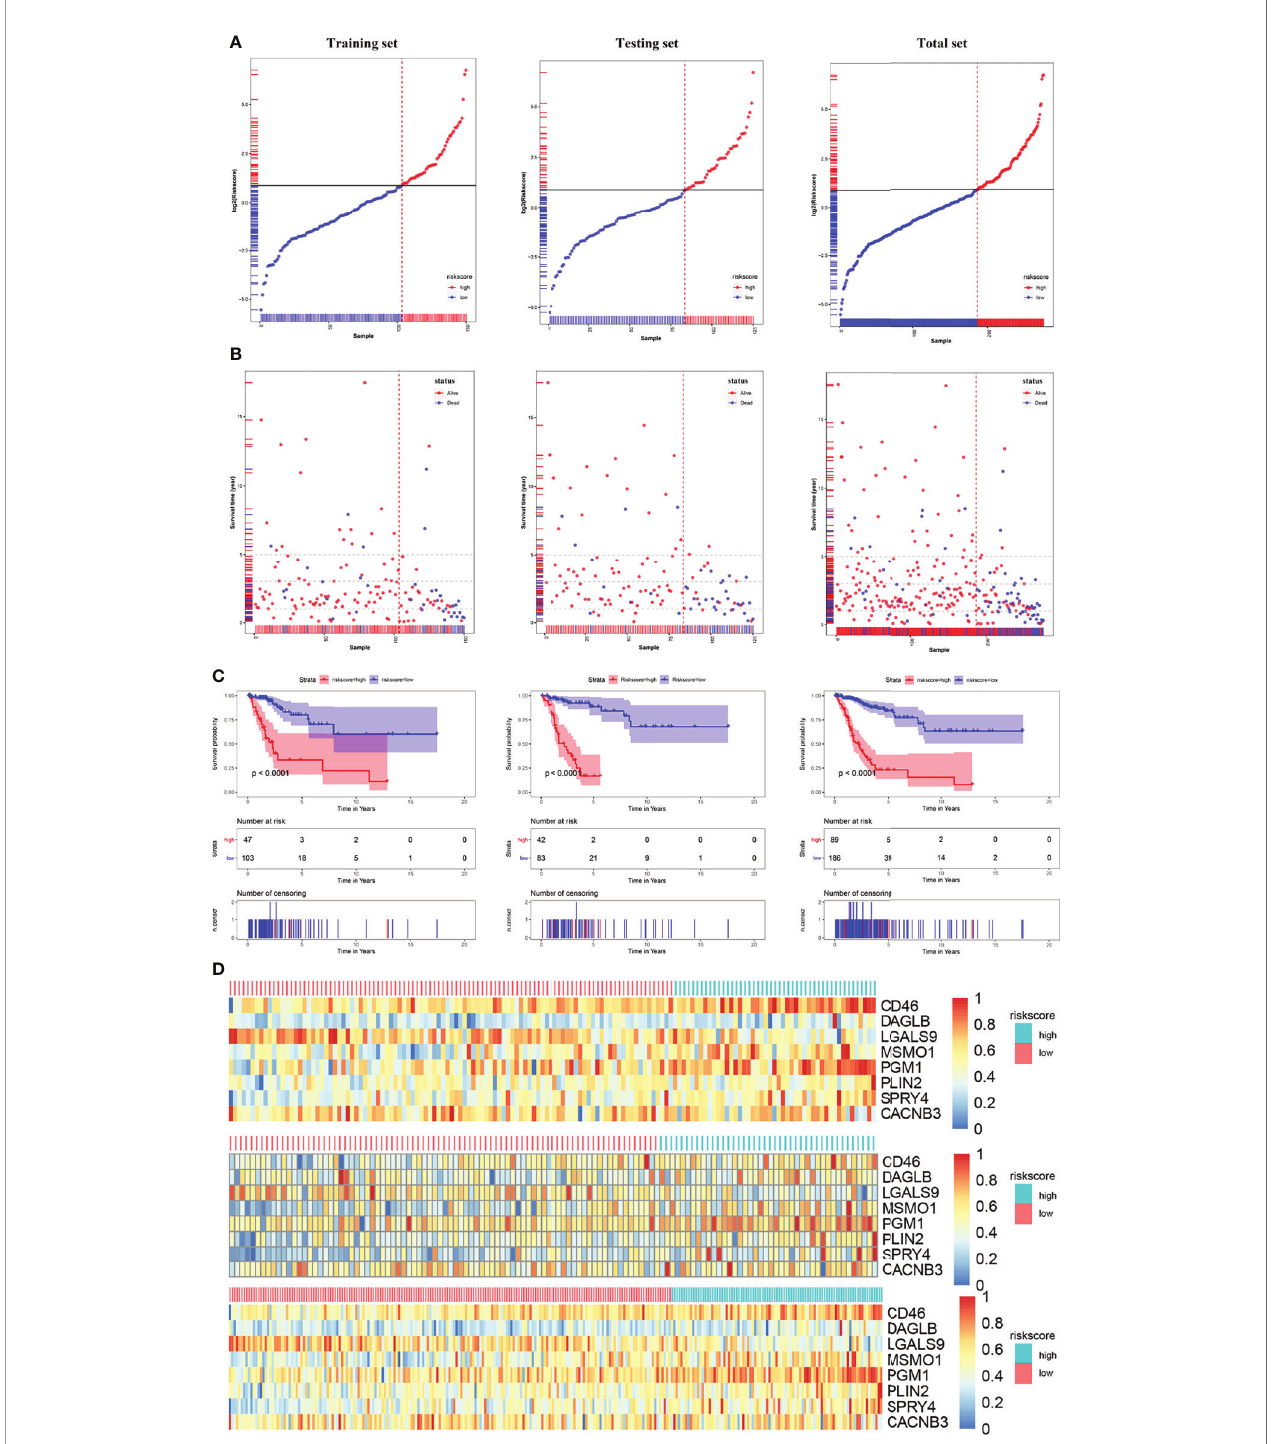
FIGURE 6 | Risk score analysis, Kaplan-Meier analysis for the validation of prognostic model in training set, testing set and entire set. (A) Rank of risk score and distribution of groups. Patients were divided into low-risk group and high-risk group based on the median value of the risk score calculated. (B) The survival status and survival time of patients ranked by risk score. (C) Kaplan-Meier suggested that high-risk score group had shorter overall survival than low-risk score group in TCGA-CESC cohort. (D) The heatmap of the expression of eight HLA-G-driven DEGs in the signature in low- and high-risk score